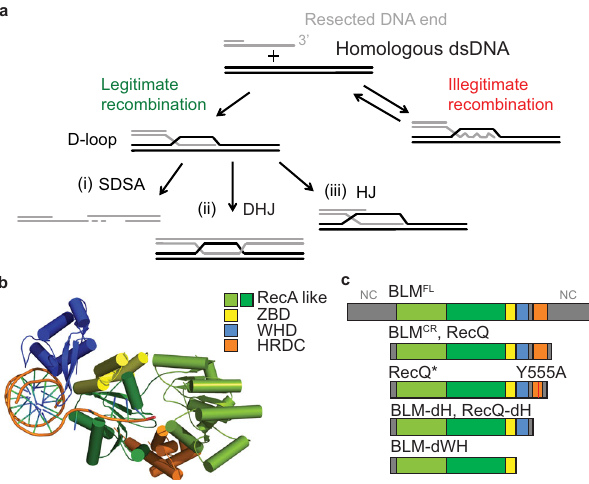
Fig. 1 D-loop processing pathways and protein constructs used. a During homologous recombination, a D-loop DNA structure (middle-left panel) is formed via the strand-exchange activity of recombinases, between the 3 ′ - ssDNA overhang of a resected DNA molecule and an intact homologous dsDNA molecule. D-loops formed between nonallelic sequences can lead to illegitimate recombination (middle right panel); such events are thought to be reversed by disruption of the joint molecule (HR quality control). In case of allelic strand exchange (legitimate recombination), different modes of processing of the D-loop structure can channel recombination into different pathways. (i) In the presence of another resected DNA break end, disruption of D-loops extended by strand synthesis could lead to the synthesis-dependent strand-annealing (SDSA) pathway, resulting in noncrossover HR products. (ii) Annealing of the other resected DNA end to the D-loop could lead to the formation of a double Holliday junction (DHJ) structure, which can then be processed by DHJ resolution or dissolution.